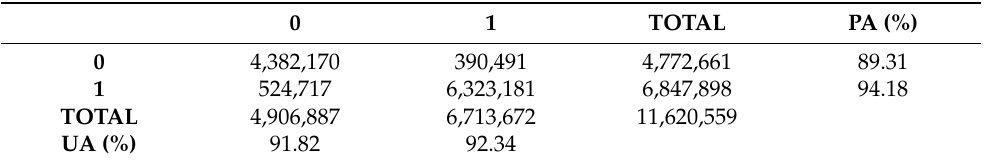
Table 6. Error matrix for Sacra Famiglia. 0 = not green; 1 = green. Rows = visual analysis; columns = NDVI + Topographic DB. UA = user’s accuracy; PA = producer’s accuracy.